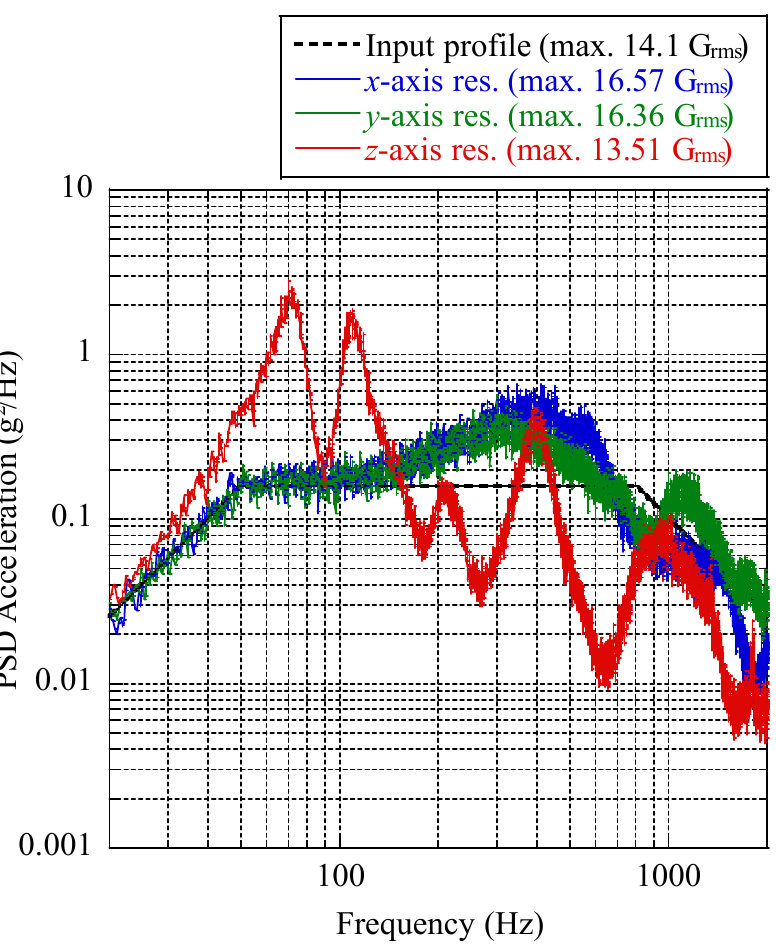
Figure 16. The results of VMLSA’s corresponding axis random vibration tests in the x -, y -, and z -axis excitations.